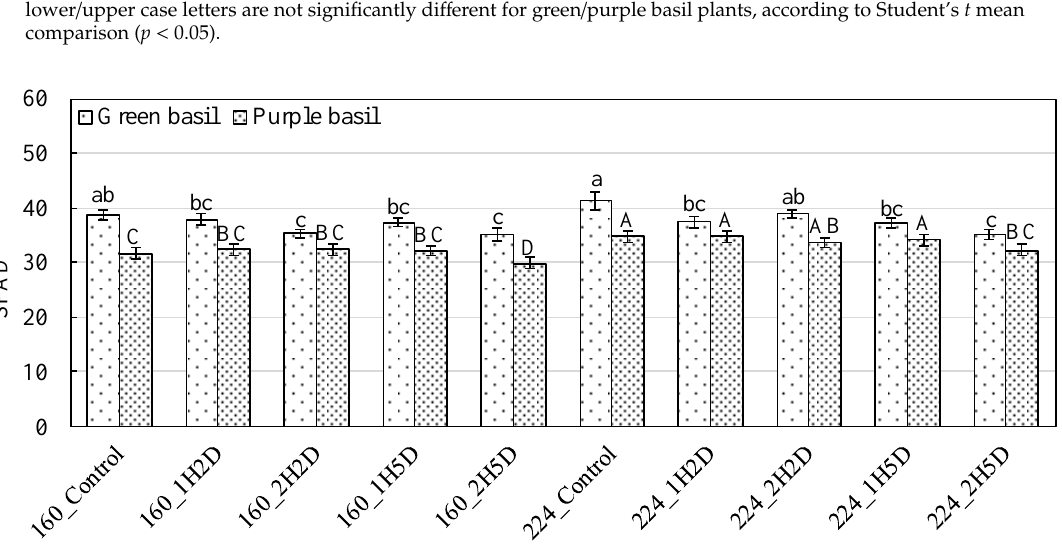
Figure 1. Relative chlorophyll concentration (soil plant analysis development (SPAD) index) of green basil ‘Improved Genovese Compact’ and purple basil ‘Red Rubin’ plants at di ff erent treatments. There were 10 treatments created by the combination of two photosynthetic photon flux density (PPFD) of 160 and 224 µ mol · m − 2 · s − 1 and five ultraviolet B (UV-B) radiation treatments, including no supplemental UV-B radiation (control), 1 h · d − 1 for 2 days (1H2D), 2 h · d − 1 for 2 days (2H2D), 1 h · d − 1 for 5 days (1H5D), and 2 h · d − 1 for 5 days (2H5D). Means followed by the same lower / upper case letters are not significantly di ff erent for green / purple basil plants, according to Student’s t mean comparison ( p < 0.05). Bars represent standard errors.